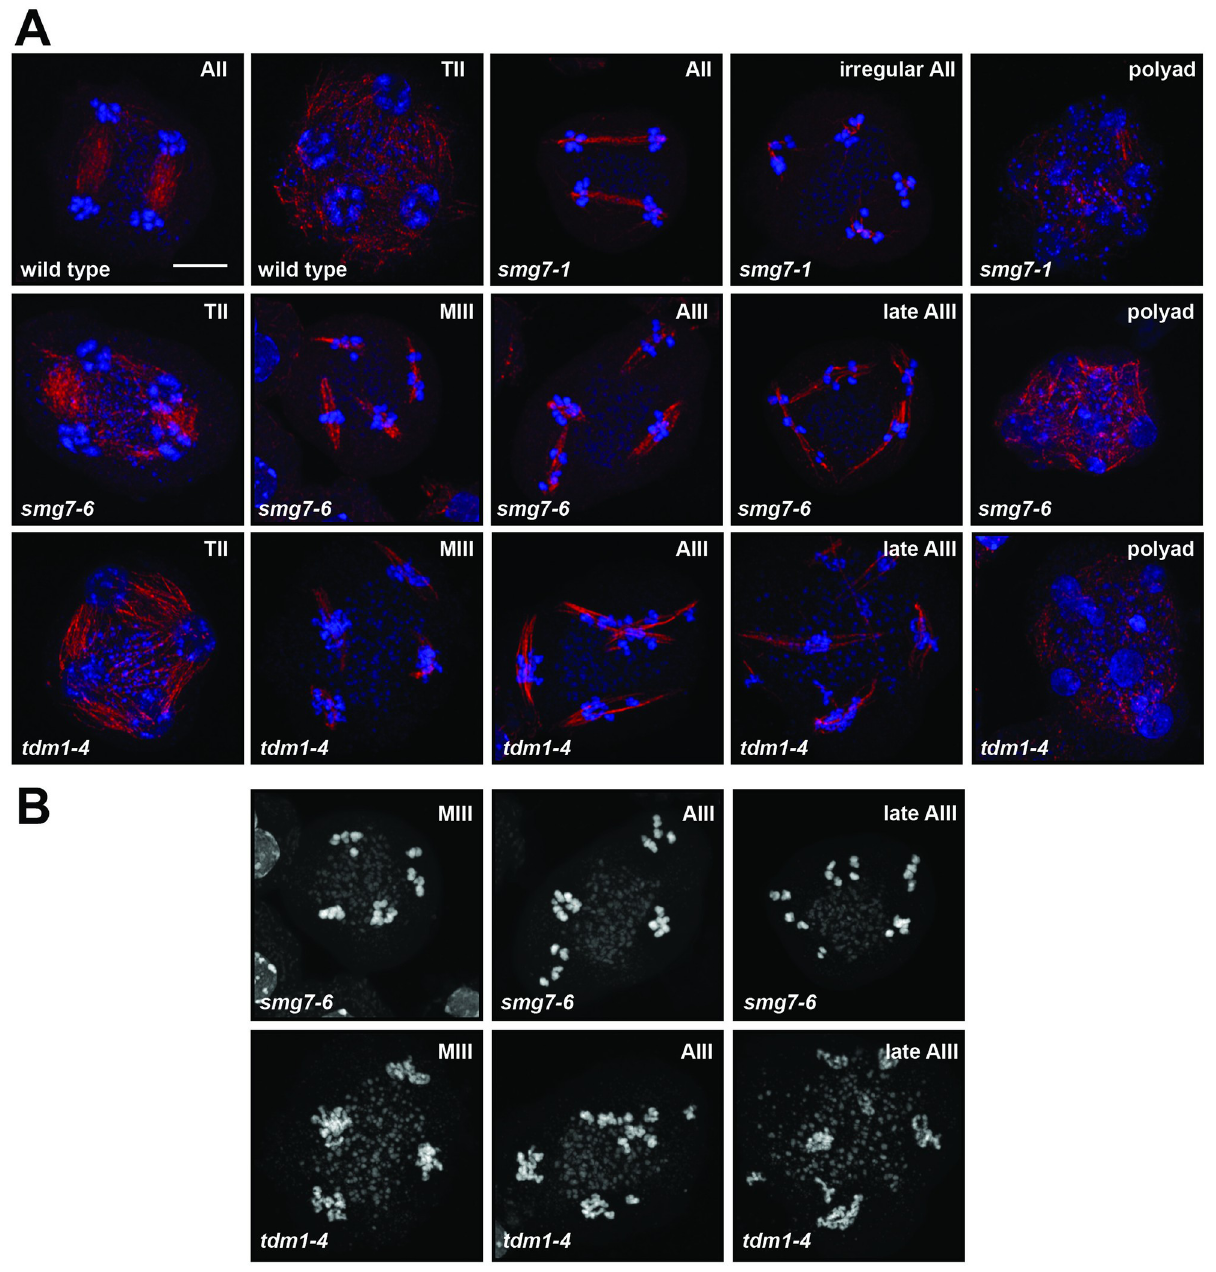
Fig 2. Meiosis in smg7 and tdm1 mutants. (A) Immunodetection of spindles using anti- α -tubulin antibody (red) in pollen mother cells. DNA is counterstained by DAPI (blue). AII—anaphase II, TII—telophase II, MIII—metaphase III, AIII—anaphase III. (B) Structure of chromosomes counterstained by DAPI in the third meiotic